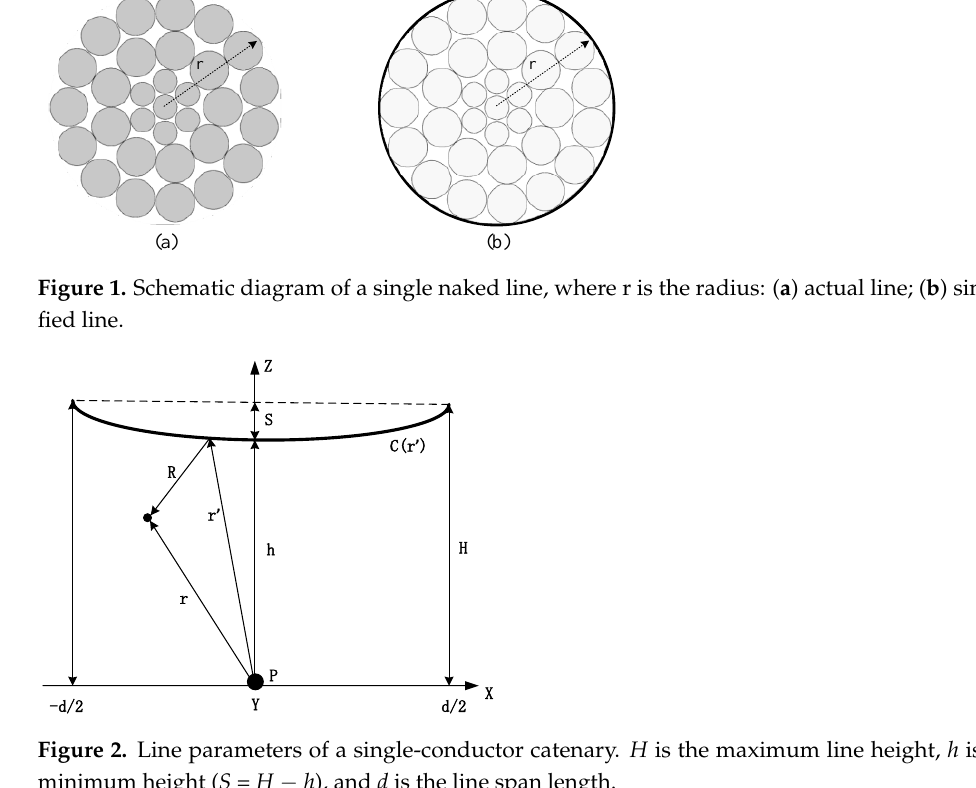
Figure 1. Schematic diagram of a single naked line, where r is the radius: ( a ) actual line; ( b ) simpli- fied line.